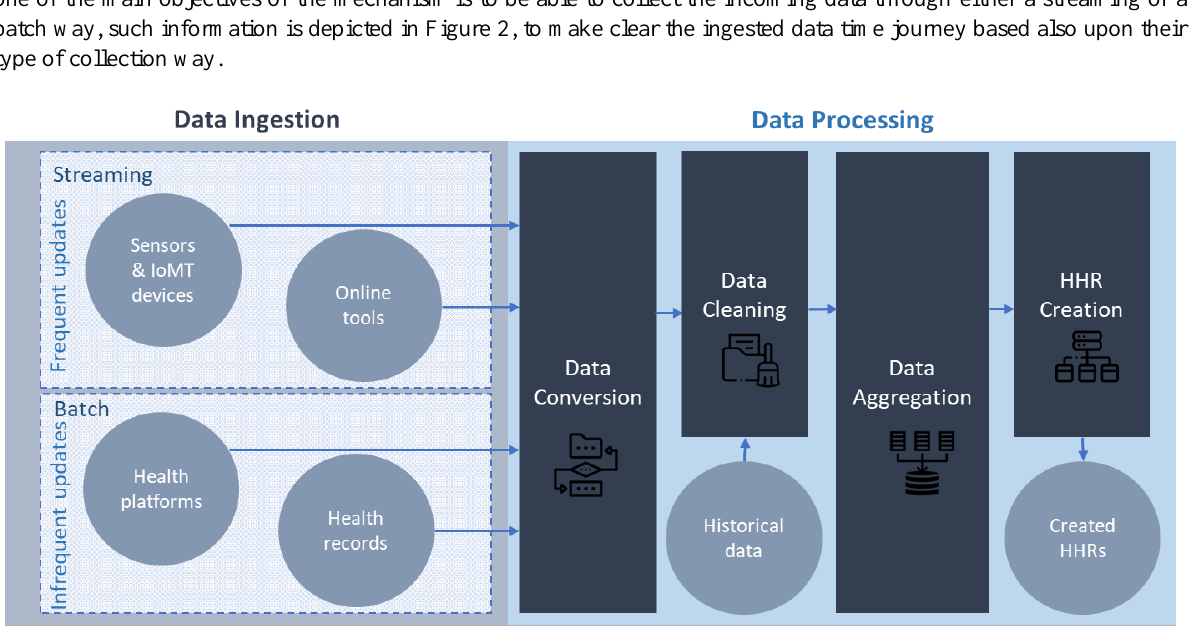
Figure 2. Data time